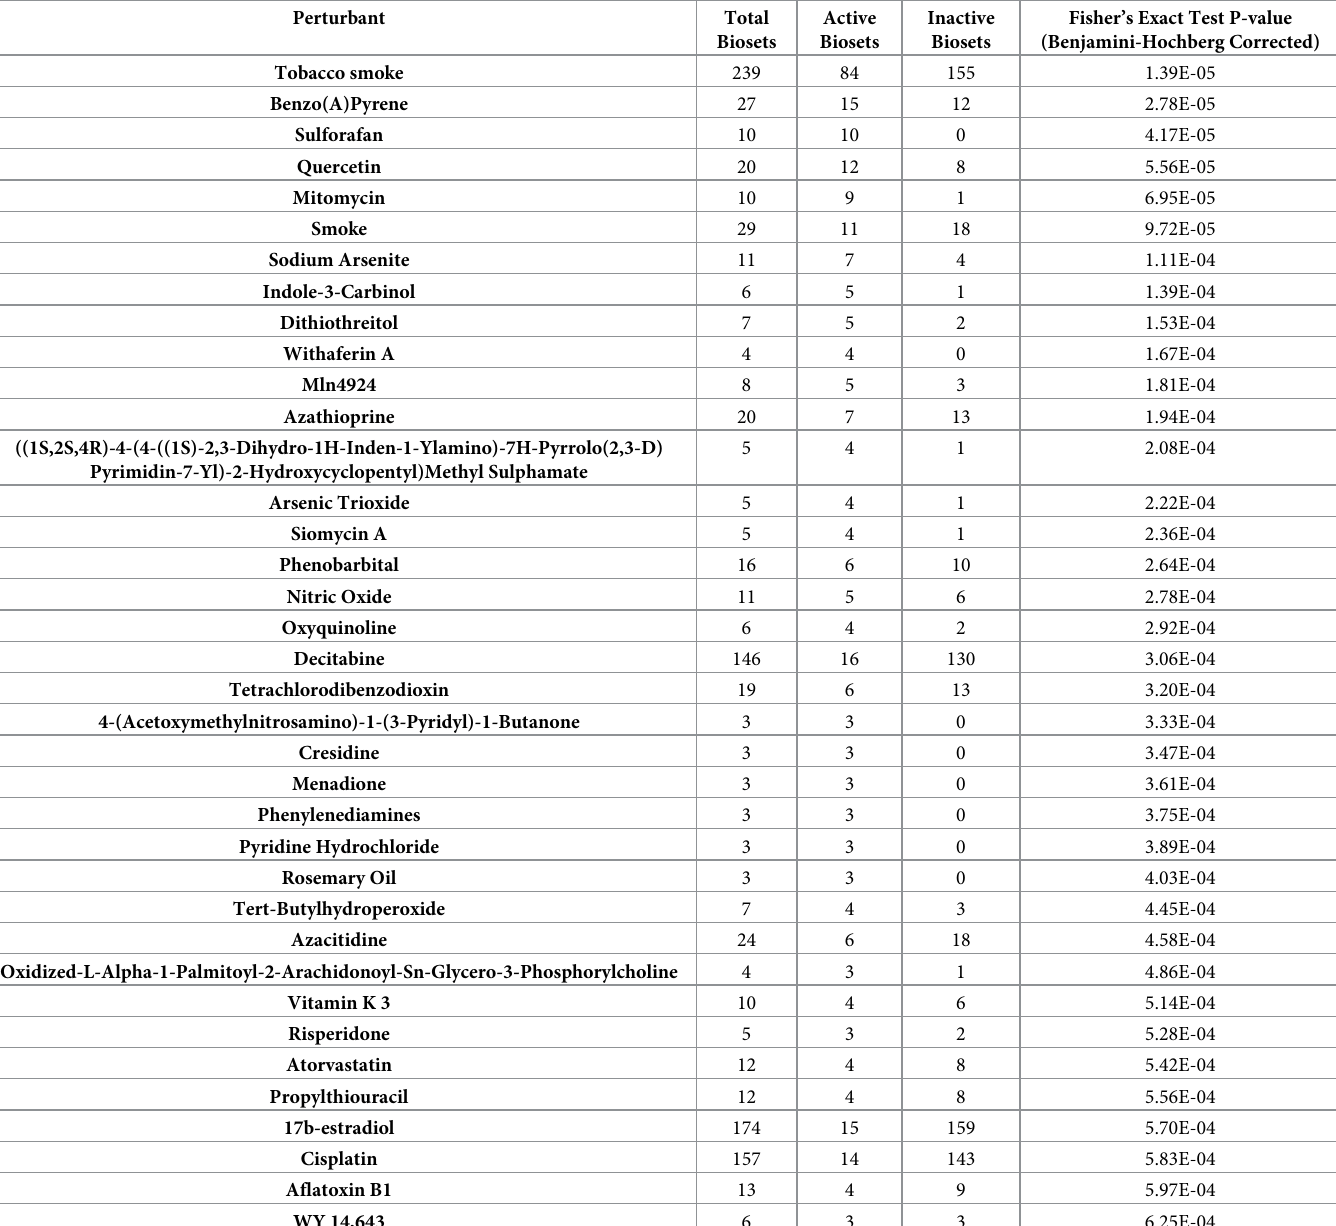
Table 2. Chemicals enriched in NRF2 active